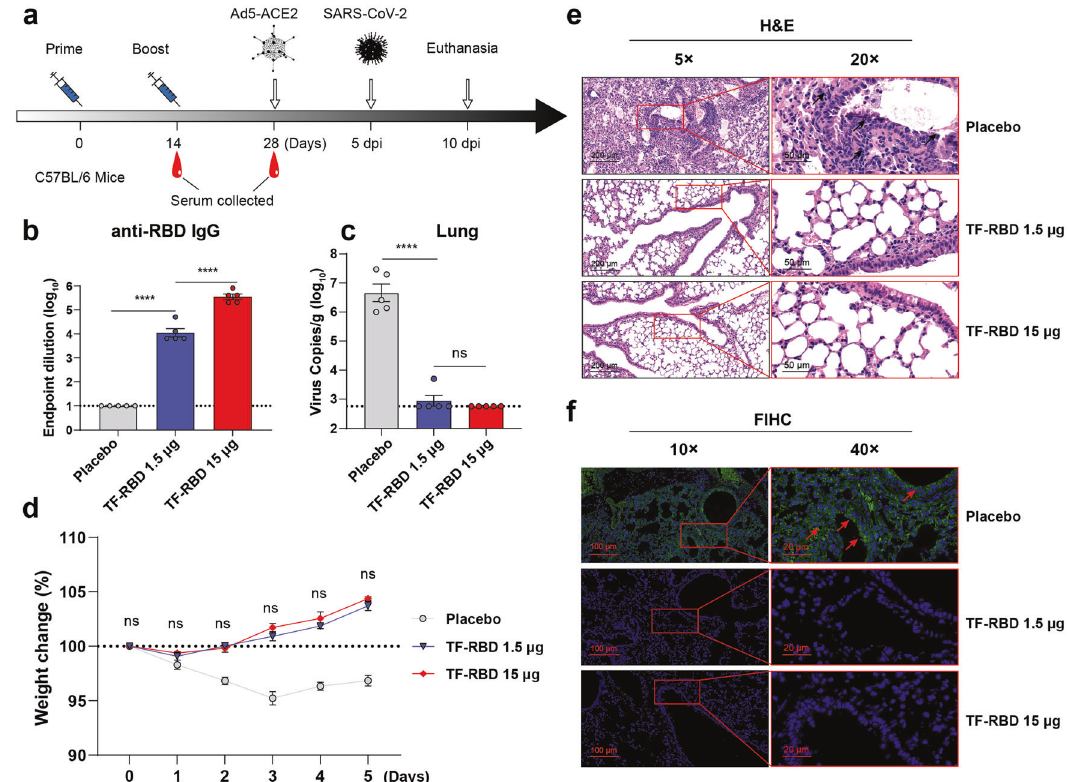
Fig. 4 Evaluation of the immune protection provided by the TF-RBD mRNA vaccine candidate during challenge in vivo. a Immunization and challenge procedures for the 1.5 and 15 μ g TF-RBD mRNA vaccine candidates in mice. Naive 6- to 8-week-old female naive C57BL/6 mice ( n = 5) were administered two doses of the vaccines via the intramuscular route. The mice were infected with Ad5-ACE2 and subsequently challenged with live SARS-CoV-2. Blood collection was performed at the indicated time points after immunization (14 days after prime immunization and 14 days after booster immunization). b The anti-RBD-speci fi c IgG antibody titers in the vaccine and placebo groups were determined by ELISA. c The viral RNA loads (copies/g) in the mouse lungs were measured. d The body weights of the mice were monitored and recorded for 5 consecutive days after the challenge. The mice were euthanized after observation. e Hematoxylin and eosin (H&E) staining to assess pathological changes in the lungs of mice at 5 dpi. The black arrows indicate the in fi ltrating in fl ame cells in the alveolar space (scale bar, left 5 × 200 μ m, right 20 × 50 μ m). f Fluorescence immunohistochemistry (FIHC) staining images of mouse lungs at 5 dpi. The red arrows show the sections incubated with the anti-SARS-CoV-2 S protein antibody, and the blue fl uorescence indicates the cell nuclei locations as determined by DAPI staining (scale bar, left 10 × 100 μ m, right 40 × 20 μ m). The dotted horizontal lines indicate the limits of quanti fi cation for the ELISA and viral RNA load data. The data are shown as the mean ± SEM. P values were determined by one-way ANOVA (ns, p > T-RBD vaccine. Mechanistically, ferritin nanoparticles signi fi cantly enhance the immunogenicity of the trimeric RBD because the nanoparticle antigens are more easily captured and presented by dendritic cells and macrophages. 54 Similar ferritin subunit vaccines are being simultaneously reported. 30 – 33 Of those, some monomer protein and RBD domain on the nanoparticle surface. A comparison of RBD-speci fi c IgG titers showed that our results (10 5.5 at the 15 μ g dose) are consistent with or higher than those